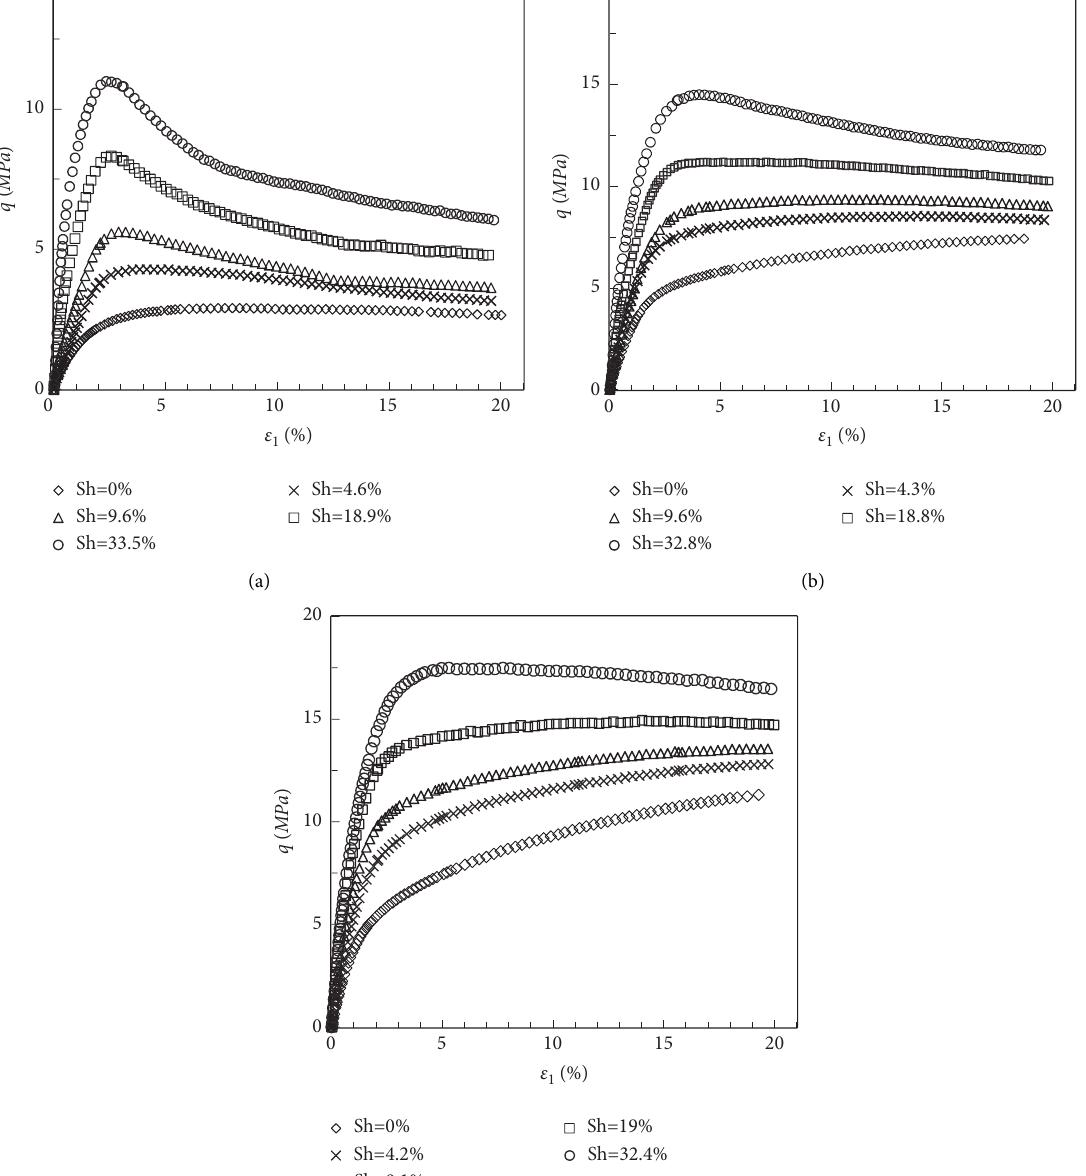
′ � 1 MPa,(b) σ ′ � 3 MPa, and (c) σ 3 3